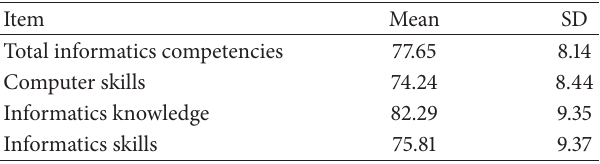
Table 2: Informatics competencies of nurse managers. Item